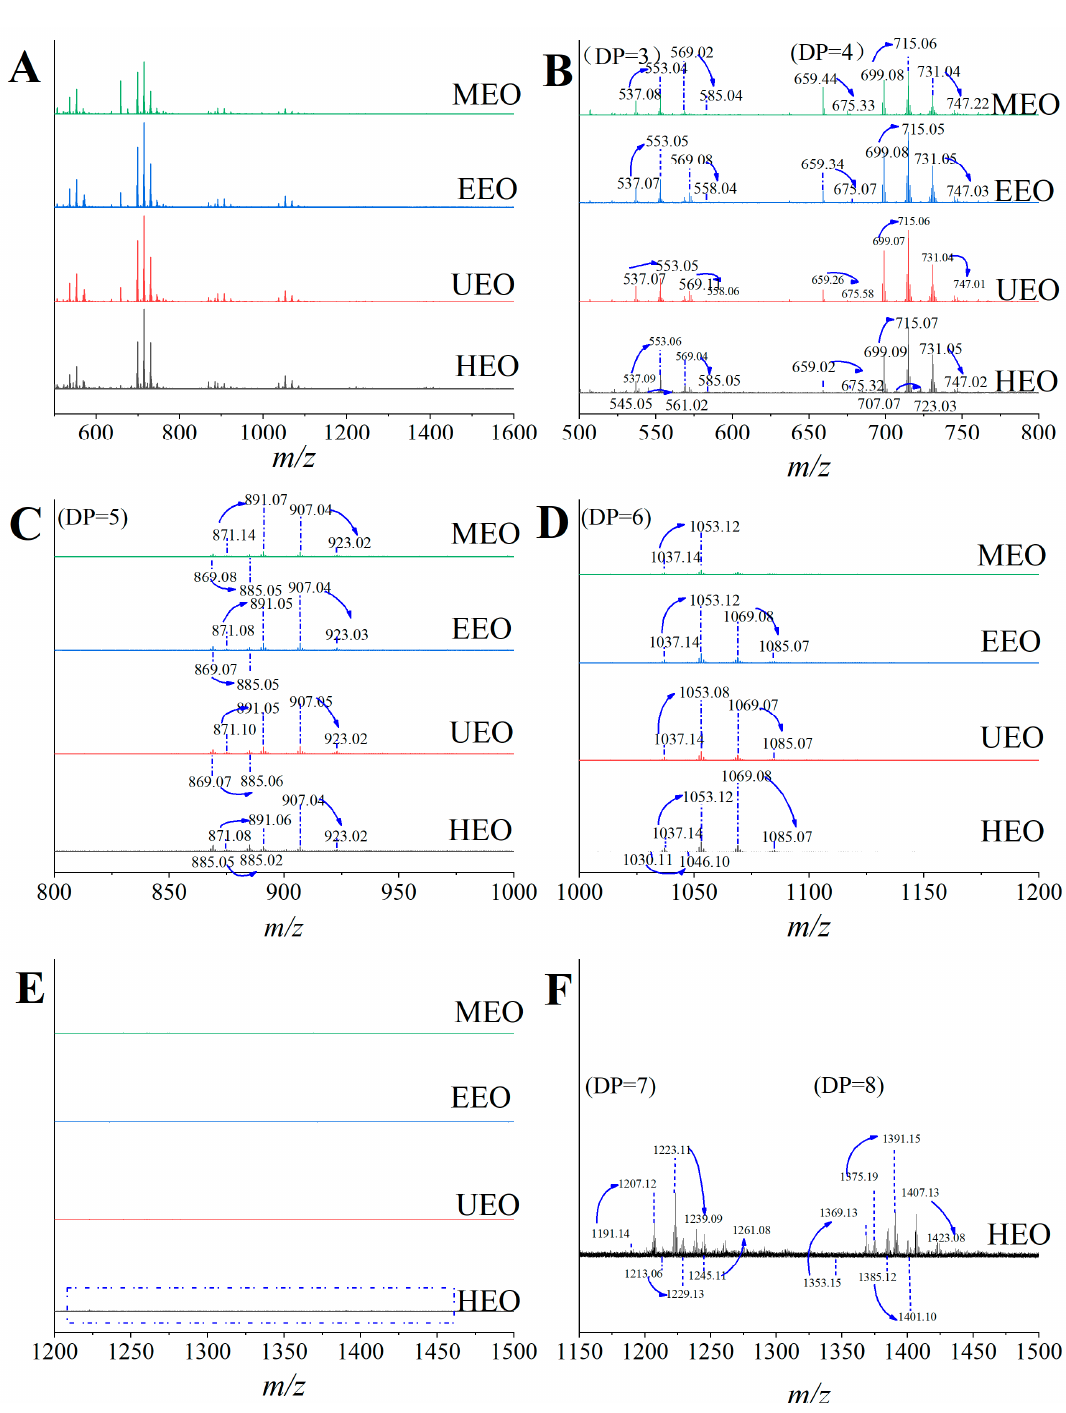
Figure 3. Molecular weight distribution analysis of EOs; ( A ) is the partial mass spectra of EOs from different extraction methods, ( B ) is the magnification of partial mass spectra of EOs between m / z 500 and 800, ( C ) is the magnification of partial mass spectra of EOs between m / z 800 and 1000, ( D ) is the magnification of partial mass spectra of EOs between m / z 1000 and 1200, ( E ) is the magnification of partial mass spectra of EOs between m / z 1200 and 1500, and ( F ) is the magnification of partial mass spectra of HEO between m / z 1180 and